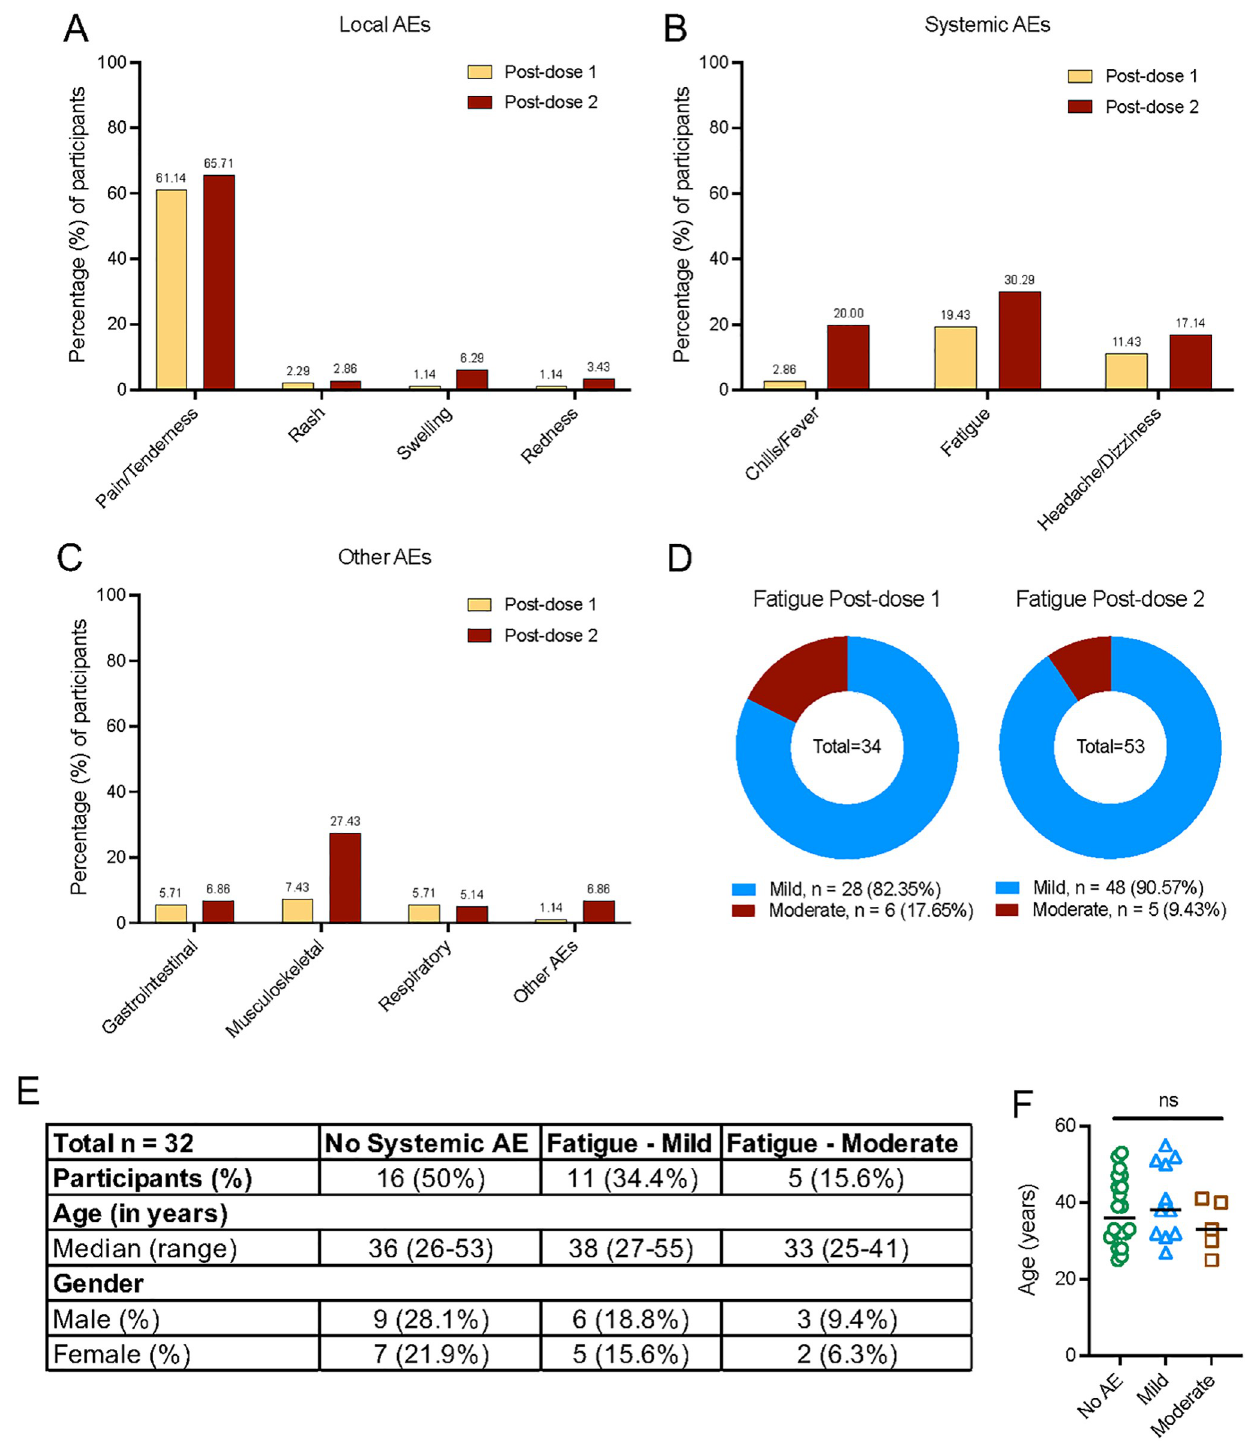
Fig 2. Reported local and systemic AEs following vaccination with the Pfizer-BioNTech (BNT162b2) vaccine ( n = 175). (A) Percentage of participants reporting local AEs at site of injection following dose 1 and 2 of vaccination. (B) Percentage of participants reporting systemic AEs following dose 1 and 2 of vaccination. (C) Percentage of participants reporting AEs associated with respiratory, gastrointestinal, musculoskeletal and other reported AEs that does not fall under any categories. (D) Percentage of participants reporting fatigue categorized by severity (mild and moderately severe) following dose 1 and 2 of vaccination. (E) Demographics of participants selected in the nested case control study. (F) Age of participants categorized based on fatigue severity. Data underlying this figure can be found in S1 Data. AE, adverse event.